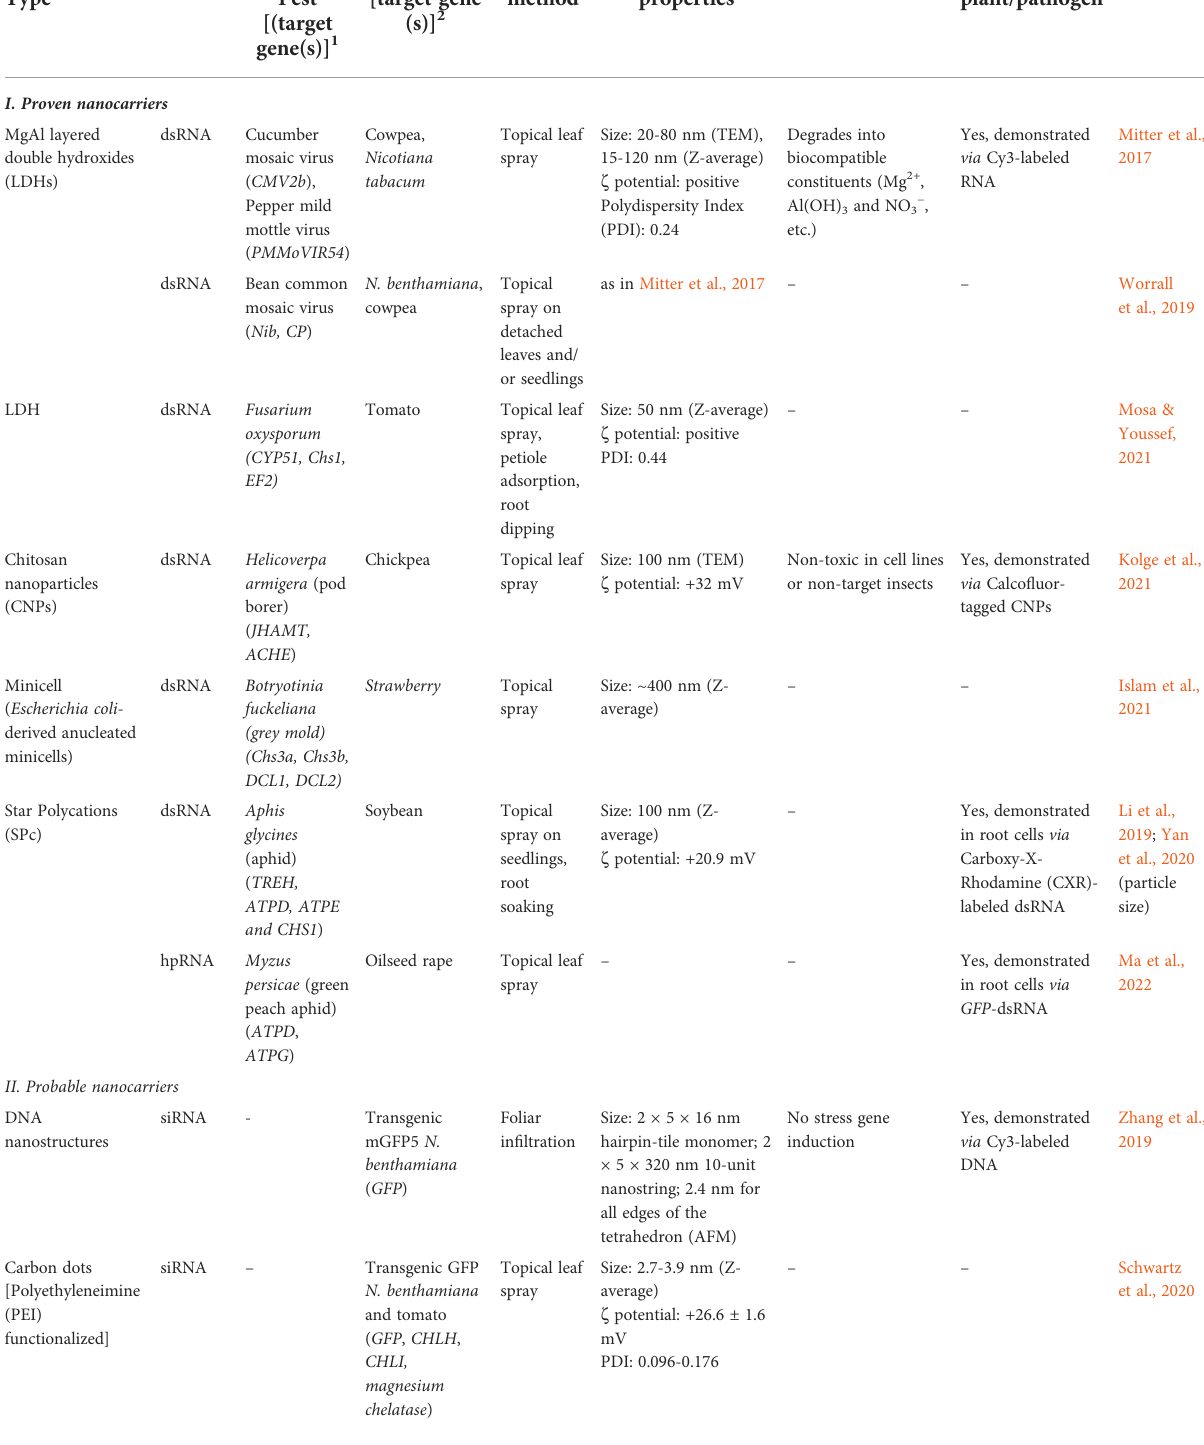
TABLE 4 List of proven and probable nanocarriers for enhancing RNA-mediated gene silencing in phytopathogenic fungi/pests through exogenous application on plants.